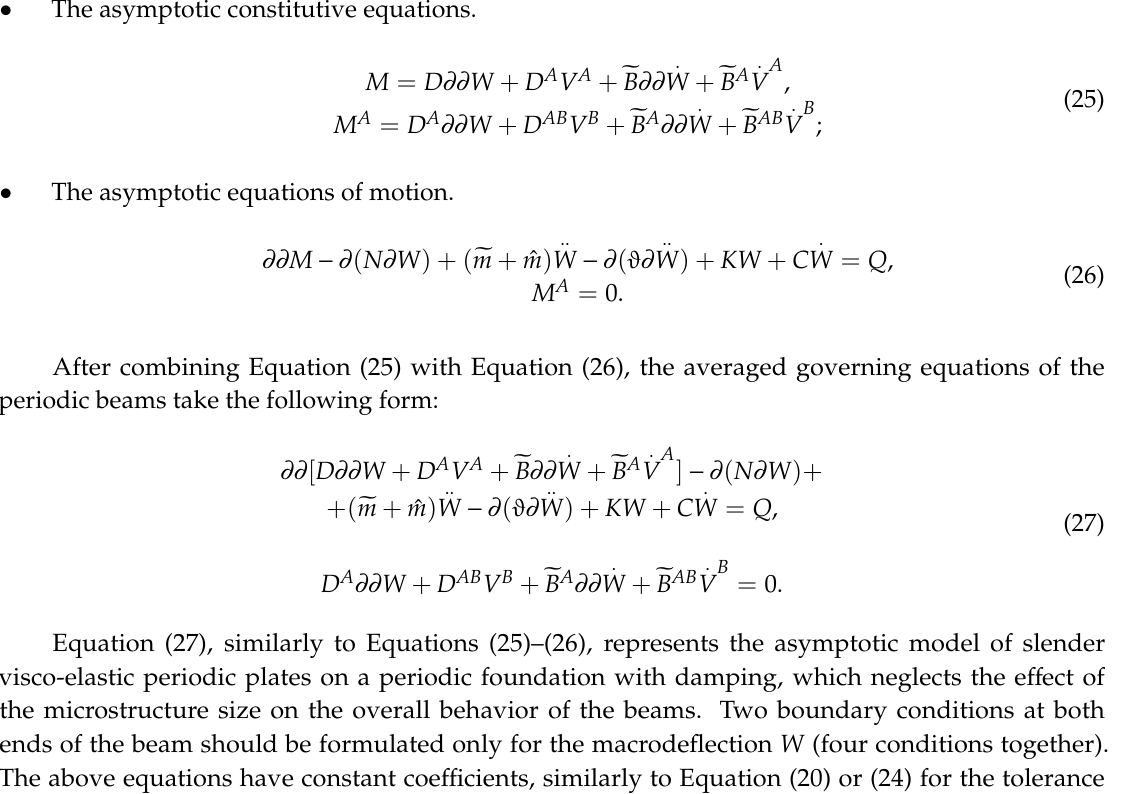
Figure 3. The periodicity cell of the considered beam. Young’s modulus E , mass density μ , height h and width b of the beam are assumed to be constant. Load q is neglected. In considerations only one fluctuation shape function g = g 1 , A = P = 1, is assumed in the form: